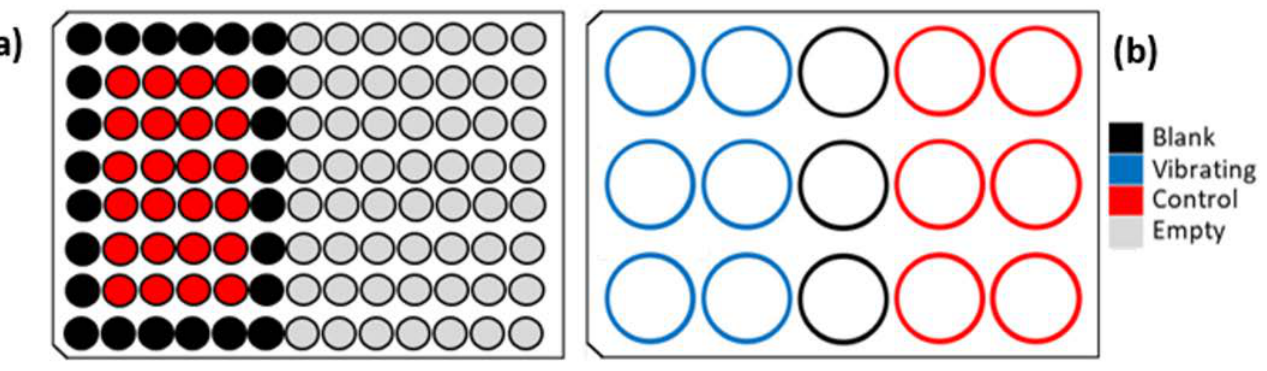
Figure 5. Filling diagram of ( a ) the reference plate and ( b ) the packaged